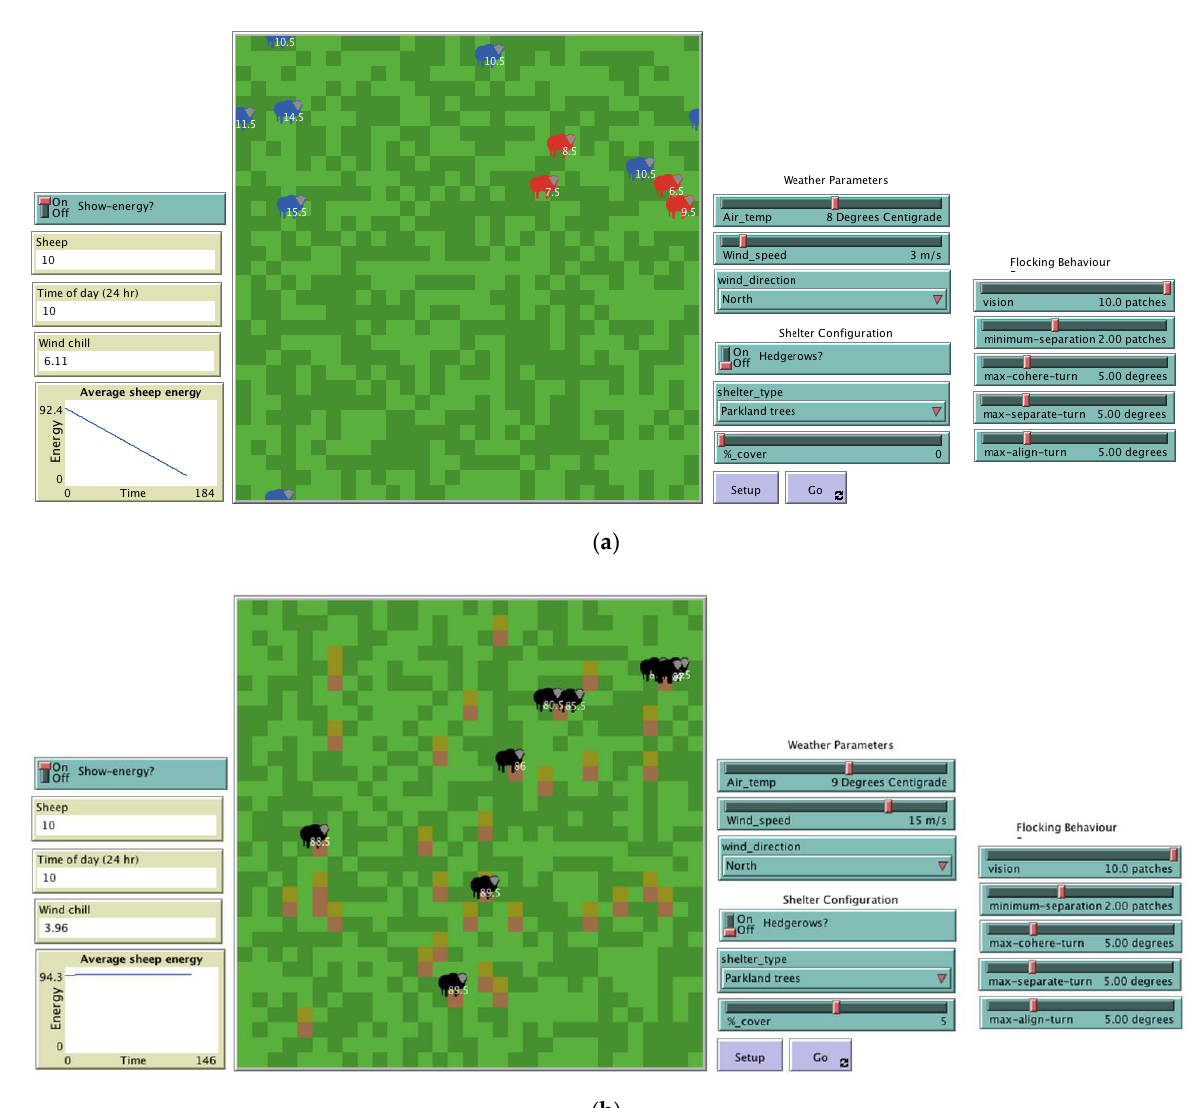
Figure 6. Net Logo model demonstrating shelter-seeking behaviour in sheep. Model parameters set using light-green boxes (sliders, switches and choosers) and model monitored using beige boxes (monitors, e.g. ‘Average sheep energy’) ( a ) No shelter is provided and a windchill below the thermal comfort zone results in a lowering of agent energy, illustrated by the colour of agents (sheep) changing from black to blue and eventually red before reaching an energy of zero and being removed ( b ) Parkland trees are incorporated into the landscape and shown as brown patches with leeward shelter effect shown in brown-green, in this scenario the energy of the agents remains comfortable in cold condition when the agents are located near shelter.